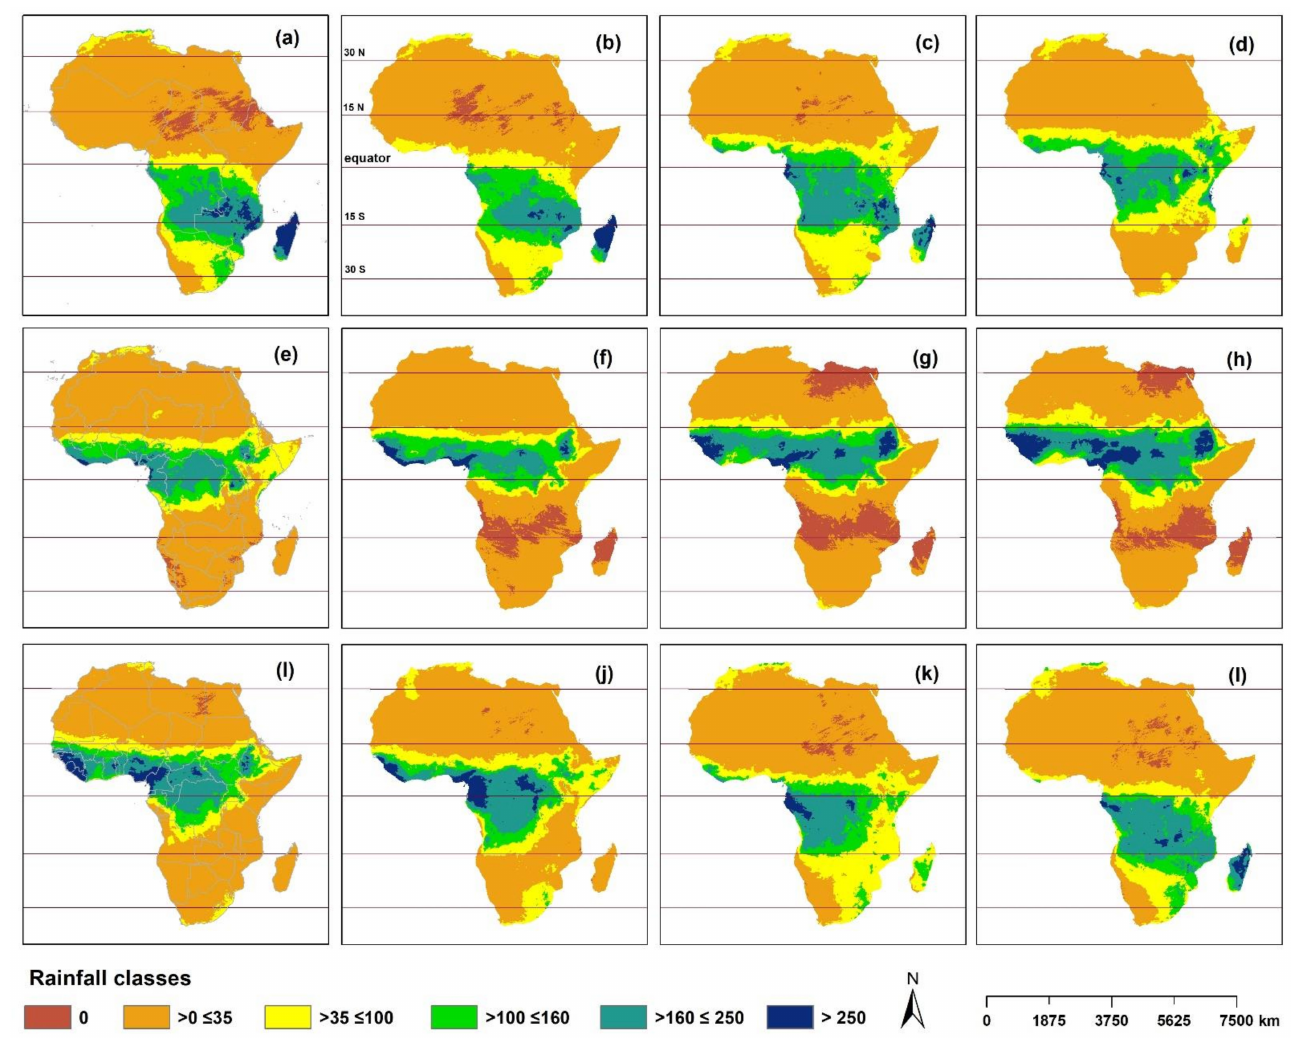
Figure 2. Spatial distribution of monthly average rainfall (mm) across Africa from 1983 to 2020.